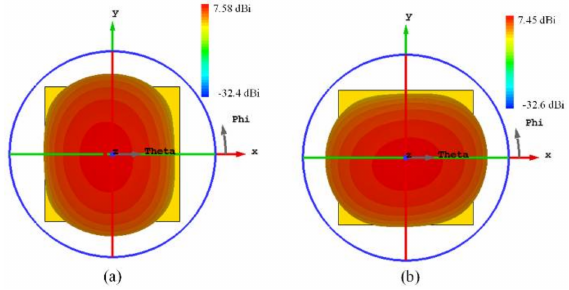
Figure 3. Simulated patterns at 5.8 GHz. ( a ) Port 1. ( b ) Port 2.